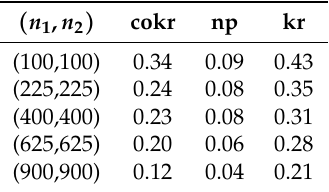
Table 5. AMSPE values obtained for several sample sizes n 1 and n 2 , for data drawn form random fields Z 1 and Z 2 with constant trends, derived from V 1 = W 2 Gaussian processes, with exponential and Matérn semivariograms, respectively. For implementation of the cokriging approach, the dependence structures of V 1 and V 2 were estimated through the exponential and Matérn models,